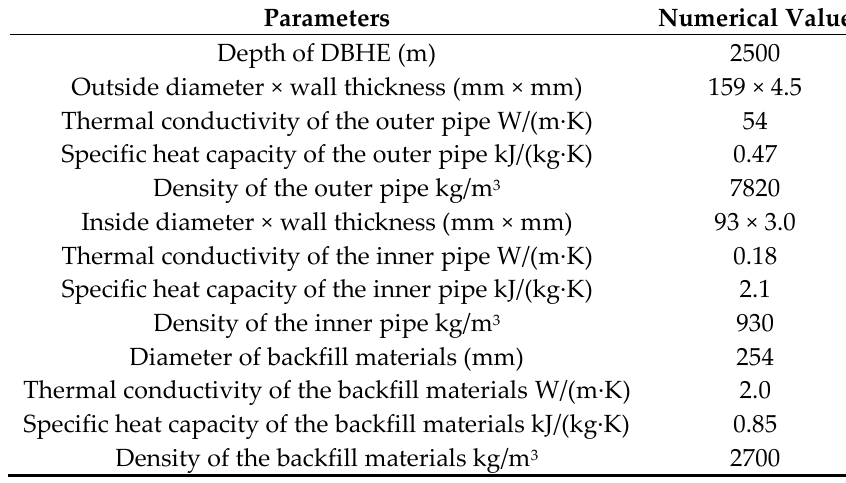
Table 2. The physical dimension and thermo-physical property of the DBHE.